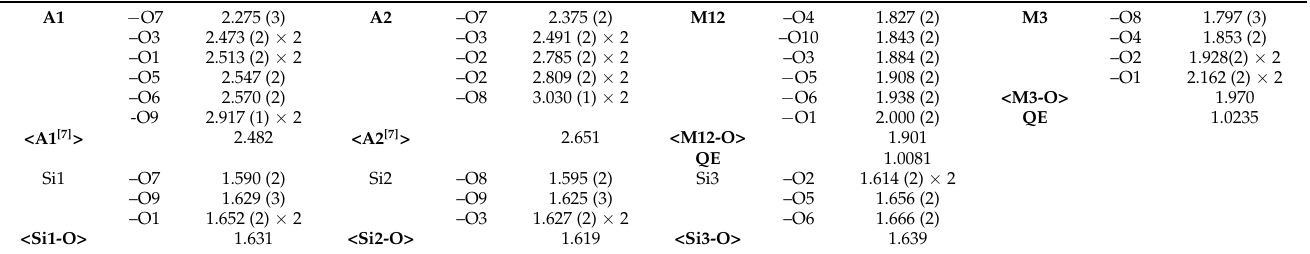
Table 6. Selected bond distances (in Å) in zoisite-(Pb). Quadratic elongation (QE) parameter calcu- lated, according to [28].